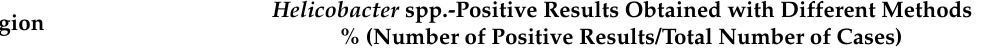
Table 3. Detection of Helicobacter spp. in the different compartments of the feline stomach according to different diagnostic